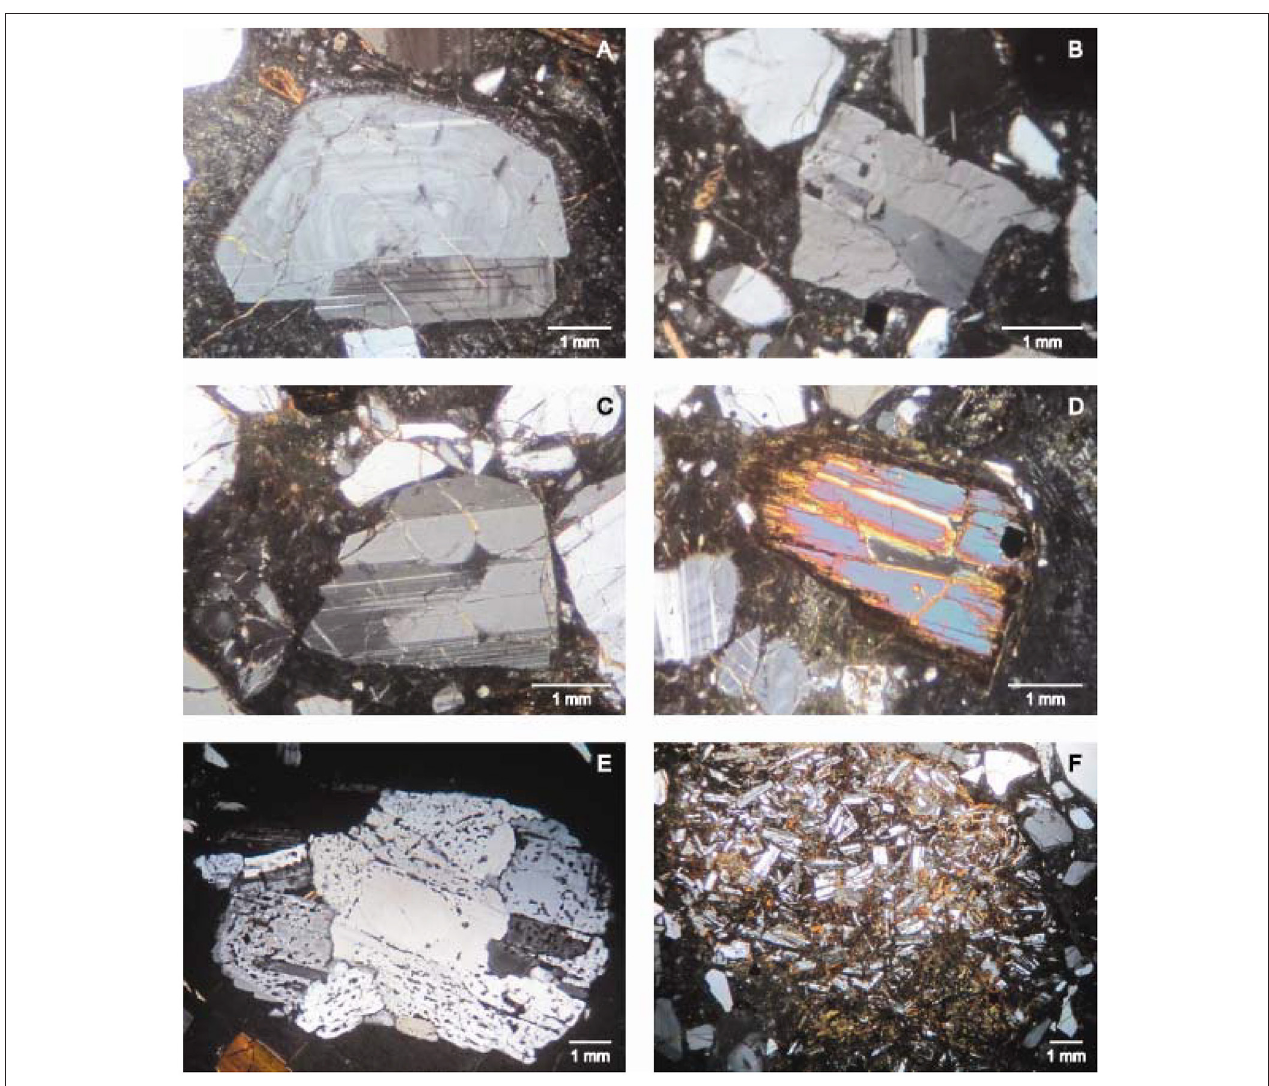
FIGURE 4 | Thin section mineralogy of 1.78Ma ignimbtite from Karymshina caldera (samples 40L-2007 and 36L-2007). Plagioclase phenocrysts exhibit (A) concentric zoning, (B) complex zoning, and (C) no zoning. Other features present in the Karymshina samples are (D) amphibole phenocrysts with reaction rims, (E) agglomerations of plagioclase crystals, some with sieve texture, and (F) autolithic xenoliths which include small phenocrysts of